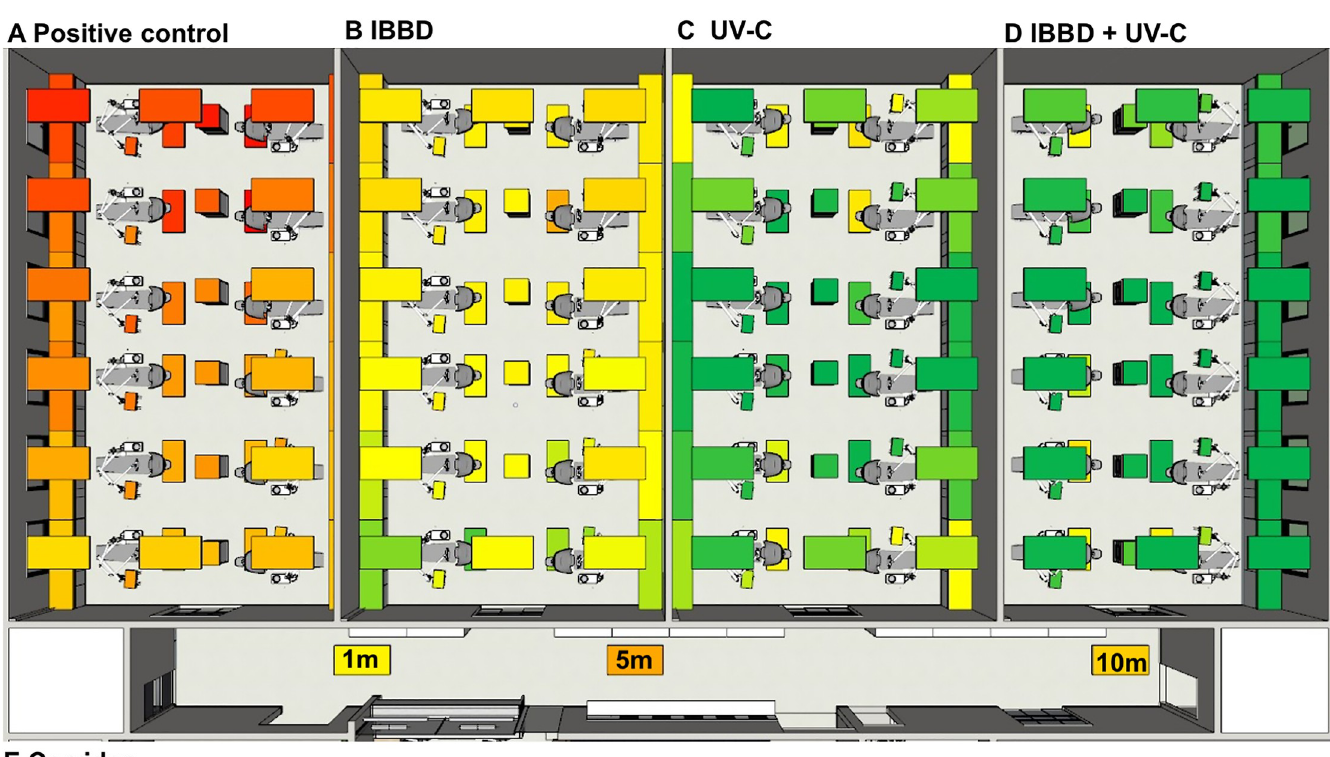
Fig 2. Heat map of the results obtained from CFU counts in clinics: Positive Control (A); IBBD; UV-C; IBBD + UV-C and Corridor. The mean difference between the positive control group and the IBBD group was, on average, 75% (B). When using UV-C device, average CFU counts had, on average, a 93% (C) and 96% reduction in IBBD+UV-C (D). To evaluate the distance that PCDP can reach from the generating source, new Petri dishes were positioned in the corridor that connect the clinics to the end of the group test without barriers. It was observed the growth of CFU in the plates positioned 1m from the input, at 5m distance and 10 m away from the generating source